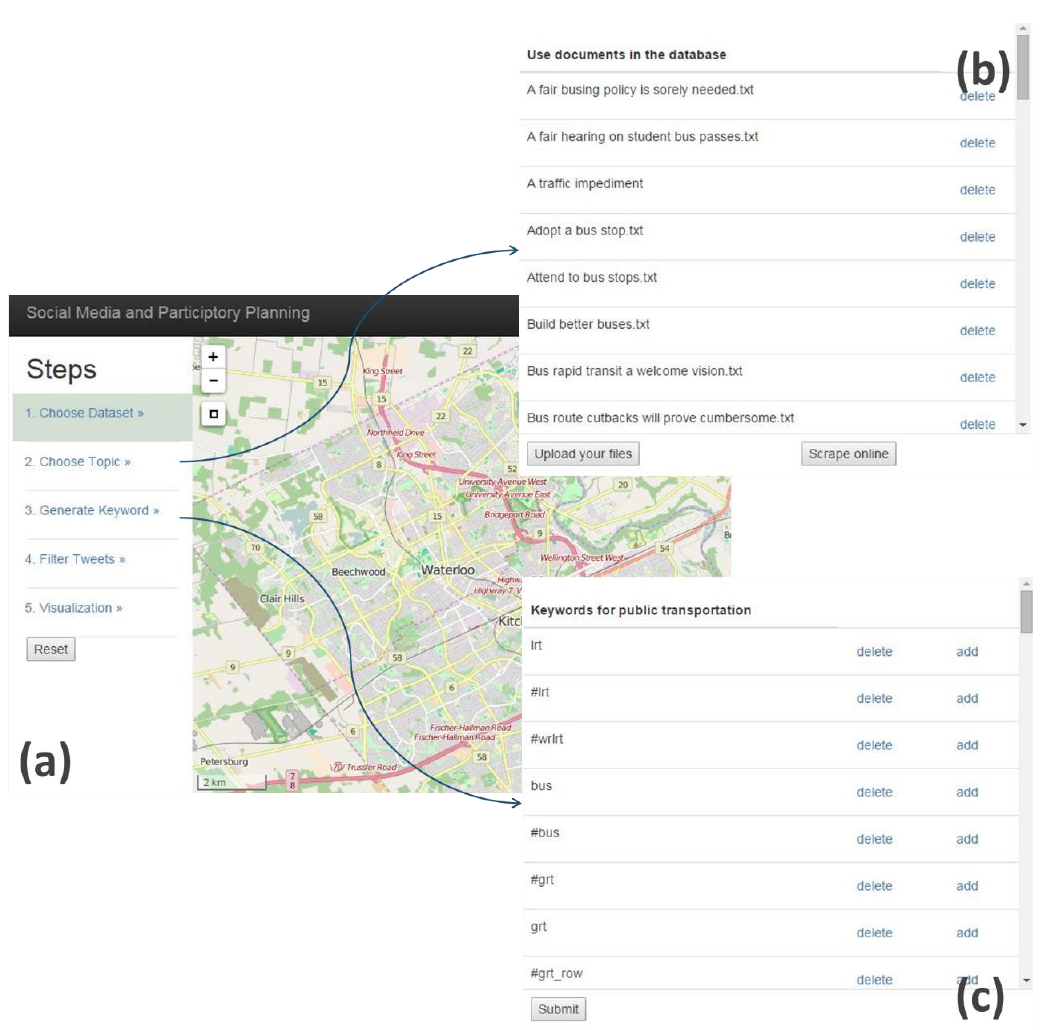
Figure 5. ( a ) the main interface of the TFA toolkit; ( b ) selecting documents for generating a customized topic lexicon; and ( c ) reviewing and modifying the auto-generated keyword list.